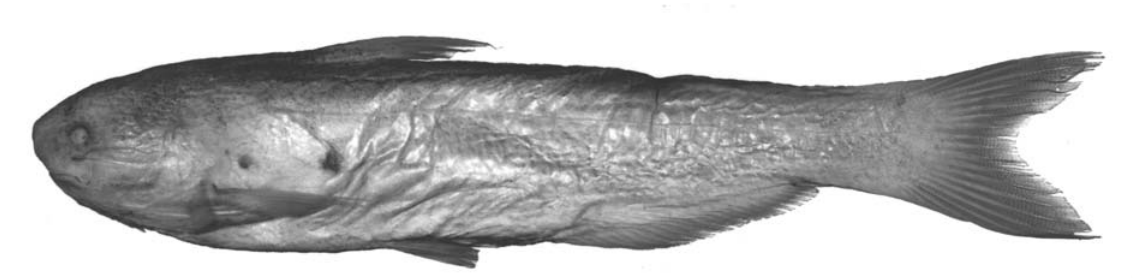
Fig. 34 . Cetopsis othonops , paratype of Hemicetopsis othonops , USNM 167853, 85.7 mm SL; Colombia, Cundinamarca, Girardot (4°18’N, 74°49’W) (dark spots on side of body are postmortem